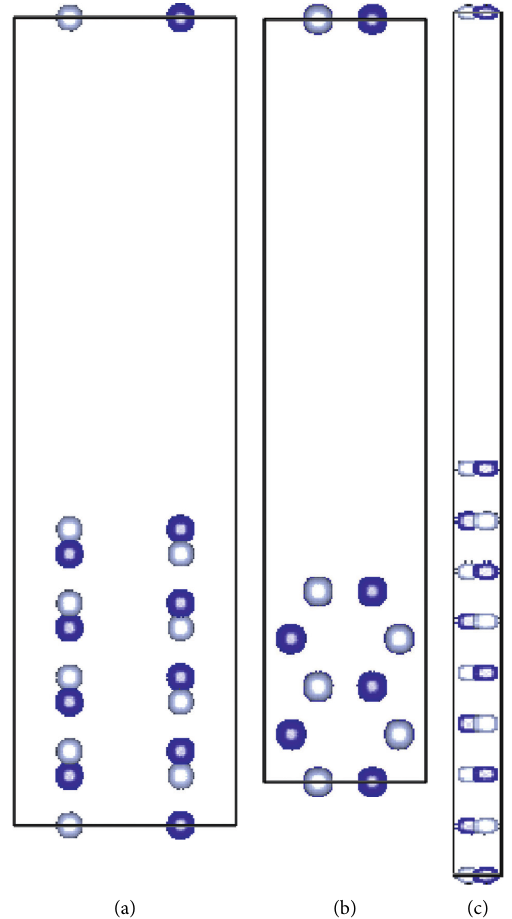
Figure 1: Schematic view of supercells for hBN along the < 001 > axis: (a) ( 101 − 0 ) slab with 9 layers, (b) ( 112 − 0 ) slab with 5 layers, and (c) (0001) slab with 9 layers. The gray and blue spheres represent B and N atoms,